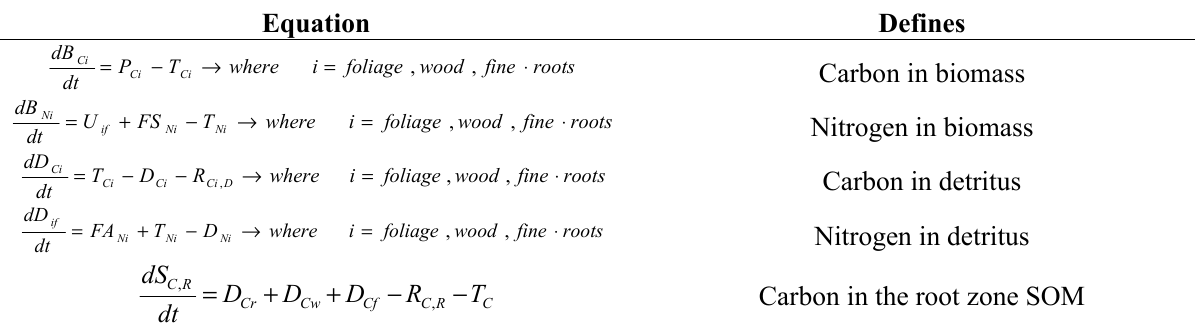
Table 2. The mass balance equations (differential equations) used to define the HJA-N